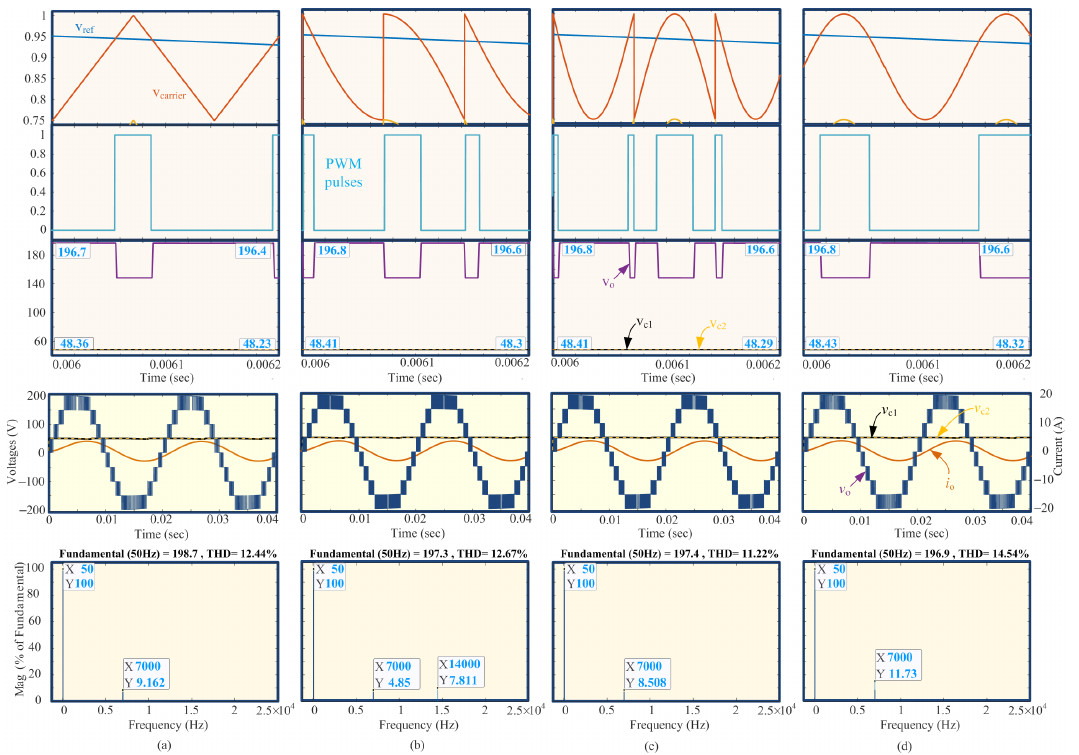
Figure 6. Simulation of PWM techniques applied to DB9LI: ( a ) Sine–Triangle PWM, ( b ) Sine–Quarter-sine PWM, ( c ) Sine–Half-sine PWM and ( d ) Sine–Sine